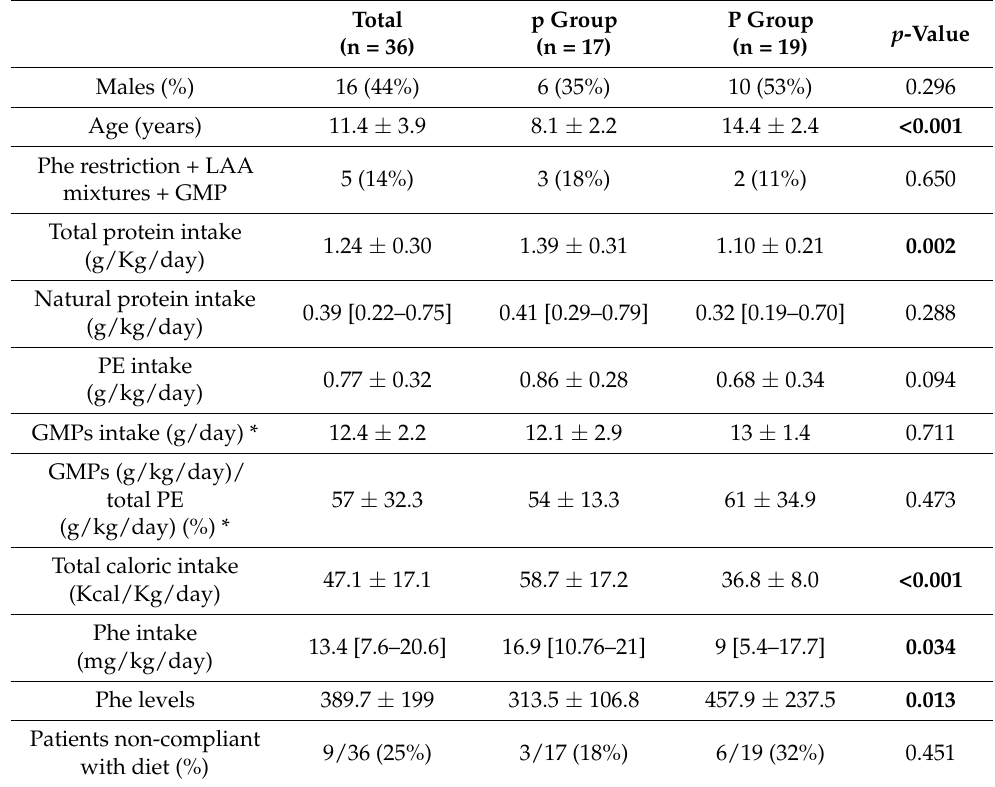
Table 1. Demographic and dietary characteristics of the